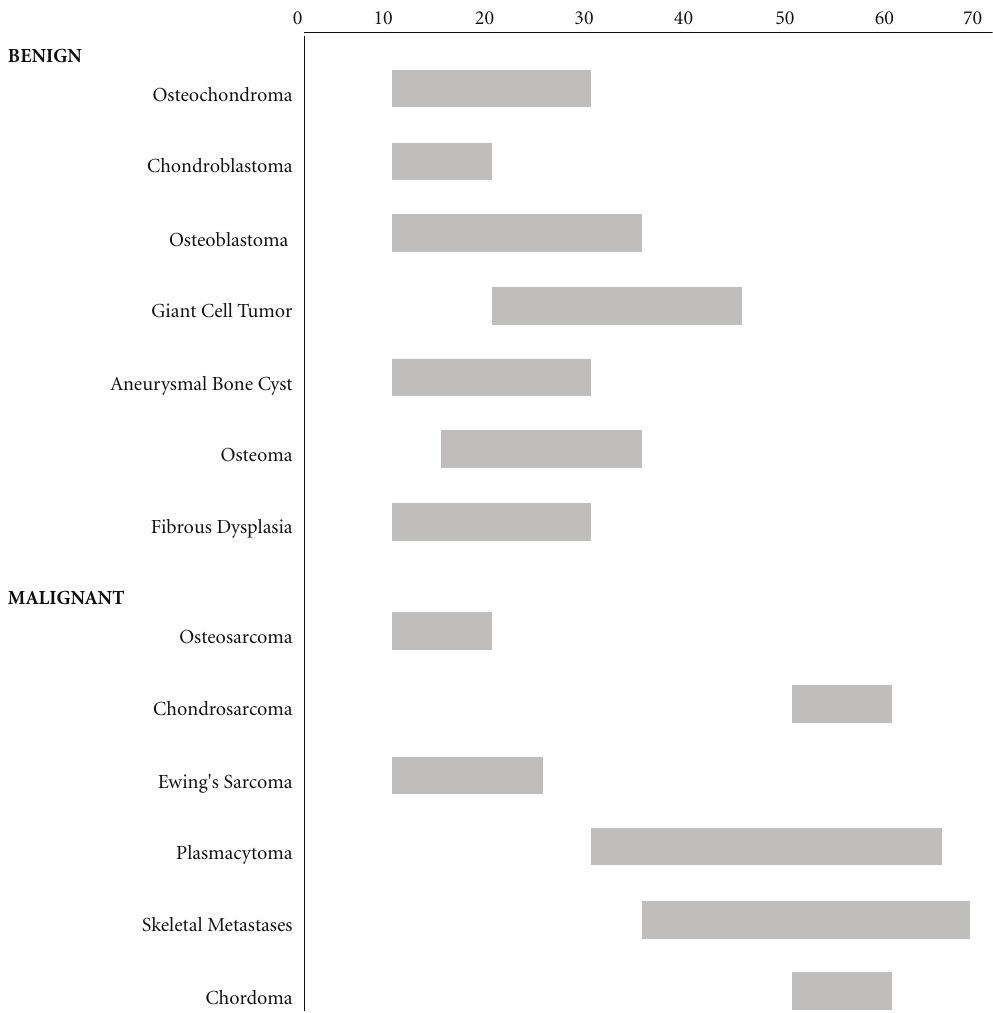
Figure 8: Typical ages for benign and malignant osseous pelvic